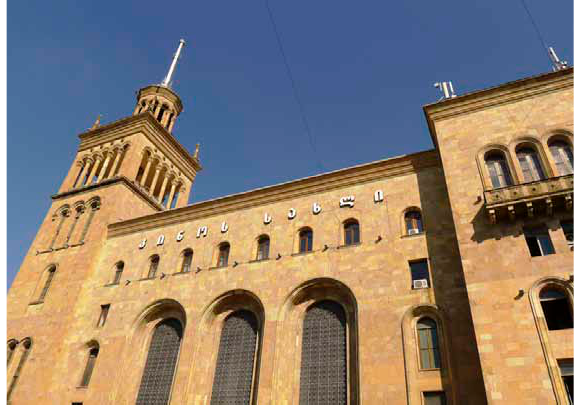
fig. 12. Palace of the academy of Sciences. Tbilisi, Georgia. fig. 13. Palace of the azerbaijan SSr Government.